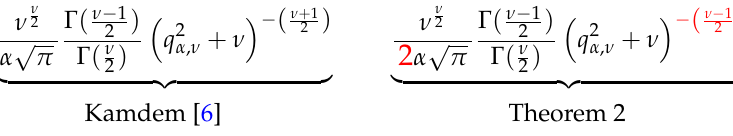
Figure 2. Comparison of the formula for expected shortfall for the multivariate Student t distribution at quantile α , ES α , from Theorem 4.2 in [6] with the accurate one from Theorem 2 for the zero-mean unit-scale